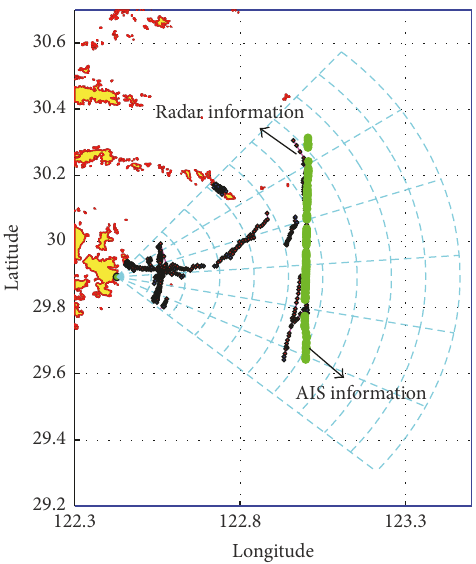
Figure 2: Results of target detection and matched AIS information.